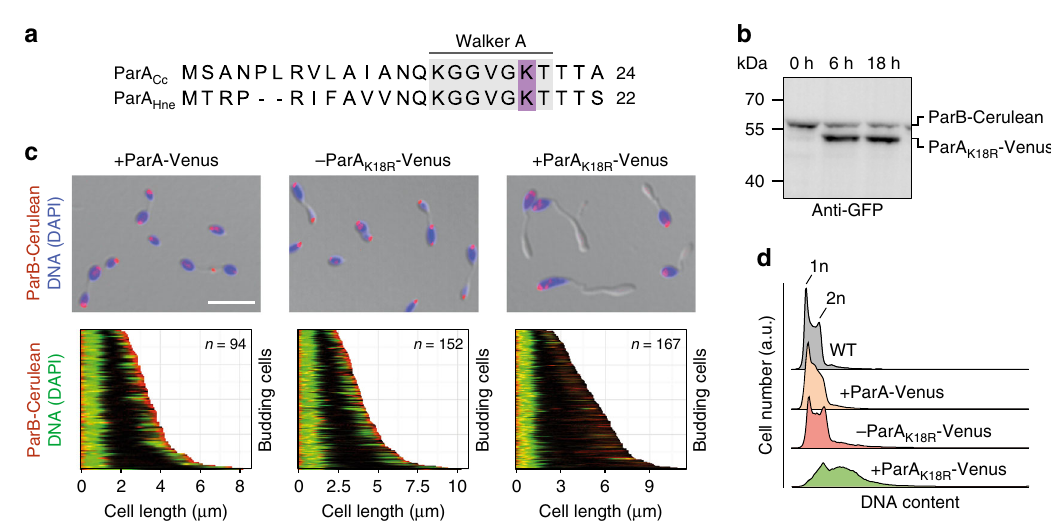
Fig. 5 Effect of impaired ParA activity on ori segregation. a Alignment of the N-terminal amino acid sequences of ParA from C. crescentus and H. neptunium . The Walker A motif is highlighted in light gray. The conserved lysine residue mutated in this work is shown in purple. b Immunoblot showing the levels of ParA K18R -Venus and ParB-Cerulean in strain AJ79 ( parB-cerulean P Cu ::P Cu - parA K18R -venus ) grown in the absence or presence of inducer. Cells were pre- grown in MB medium, induced with 0.5 mM CuSO 4, and cultivated for another 18.5 h. Samples were taken at the indicated time points and subjected to immunoblot analysis with anti-GFP antibodies. A full scan of the immunoblot is shown in Supplementary Fig. 9b. c Localization of ParB-Cerulean and chromosomal DNA in cells producing a dominant negative ParA variant. Strains AJ80 ( parB-cerulean P Cu ::P Cu - parA-venus ) and AJ79 ( parB-cerulean P Cu ::P Cu - parA -venus ) were pre-grown in MB medium and induced for 4.5 h with 0.3 mM CuSO K18R 4 . Subsequently, cells were treated for 25 min with DAPI to stain the nucleoids and subjected to microscopic analysis. A culture of strain AJ79 grown in the absence of inducer was analyzed as a control. Bar: 5 µ m. The demographs at the bottom show the subcellular distribution of the ParB-Cerulean and DAPI signals in budding cells from the cultures described above, with the mother cell body positioned to the left and the bud positioned to the right. Black indicates the absence of speci fi c signals. d Flow cytometric analysis of the chromosome content in cells producing a dominant negative ParA variant. Strains AJ80 ( parB-cerulean P Cu ::P Cu - parA-venus ) and AJ79 ( parB-cerulean P Cu ::P Cu - parA K18R -venus ) were grown as described in ( d ) and treated for 25 min with Vybrant DyeCycle Orange to stain the chromosomal DNA prior to analysis ( n = 30.000